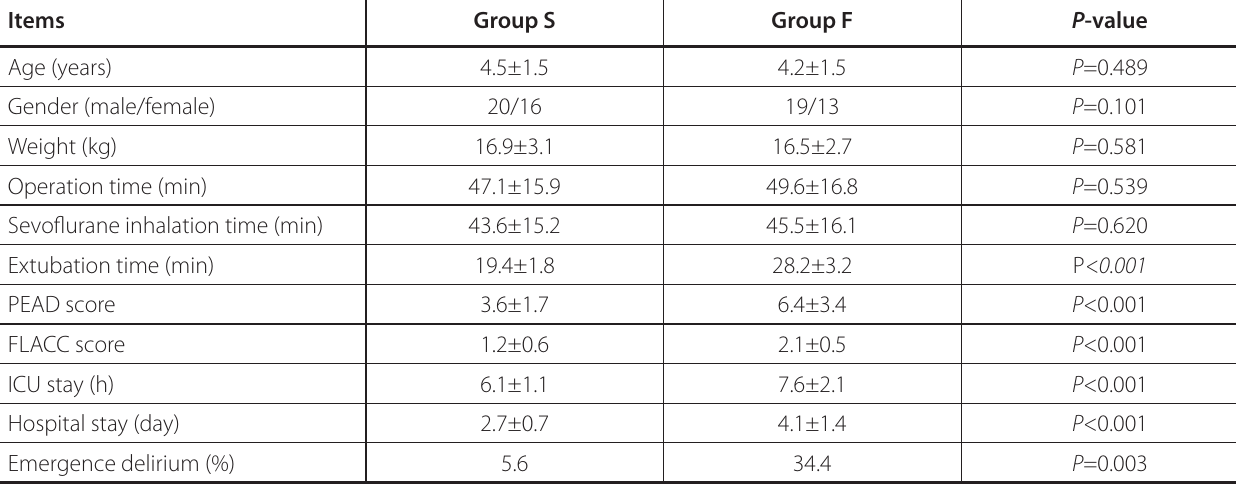
Table 1 . General information in both groups.